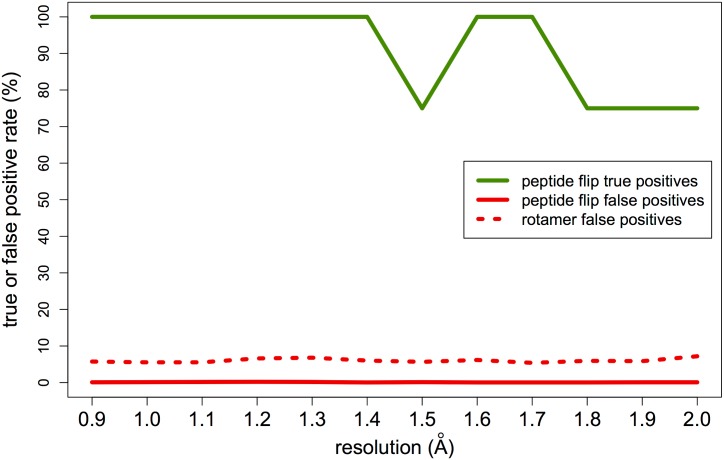
True vs. false positives with synthetic data.Peptide flip true positives = percent of peptide flips in the actual synthetic model that are present in the qFit 2.0 model. Peptide flip false positives = percent of residues with a peptide flip in the qFit 2.0 model that are not in the actual synthetic model. Rotamer false positives = percent of sidechain rotamers (as defined by MolProbity [12, 34]) in the qFit 2.0 model that are not in the actual synthetic model. True positives in green; false positives in red. Peptide flips in solid lines; rotamers in dotted line. Data is averaged over all four synthetic datasets (corresponding to the four peptide flip geometry clusters in Fig 2) and all three mainchain amplitudes are considered; see Methods.